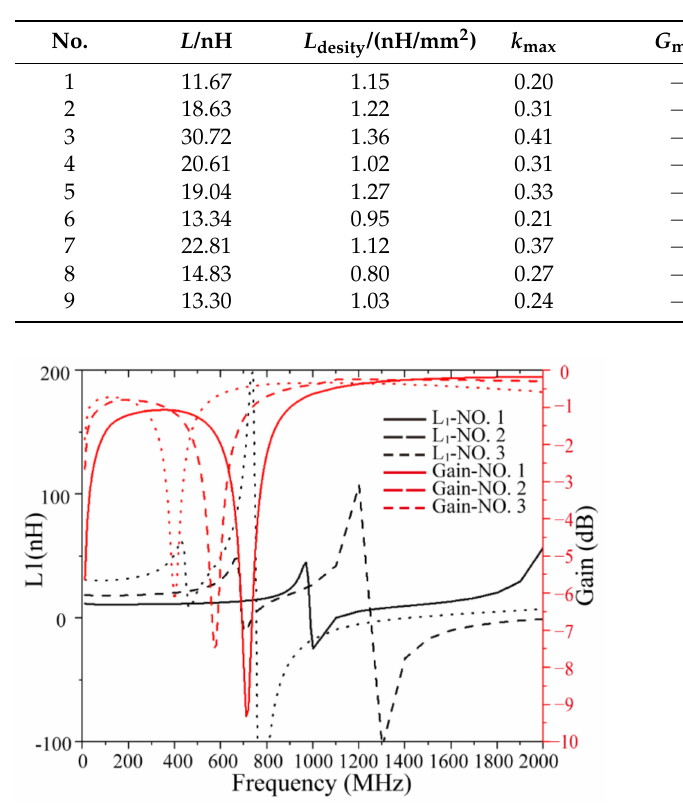
Table 4. Simulation result of toroidal transformer with air core.